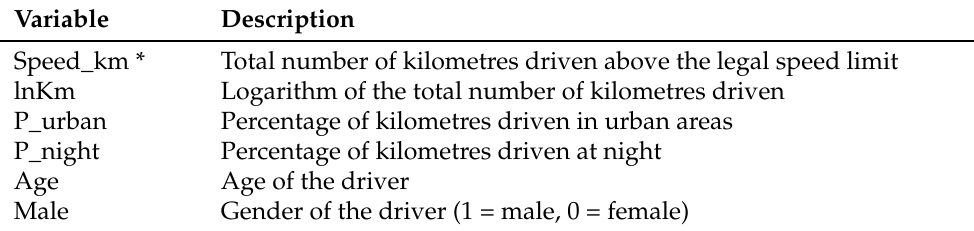
Table 1. Definition of variables in the telematics data set for 2010.